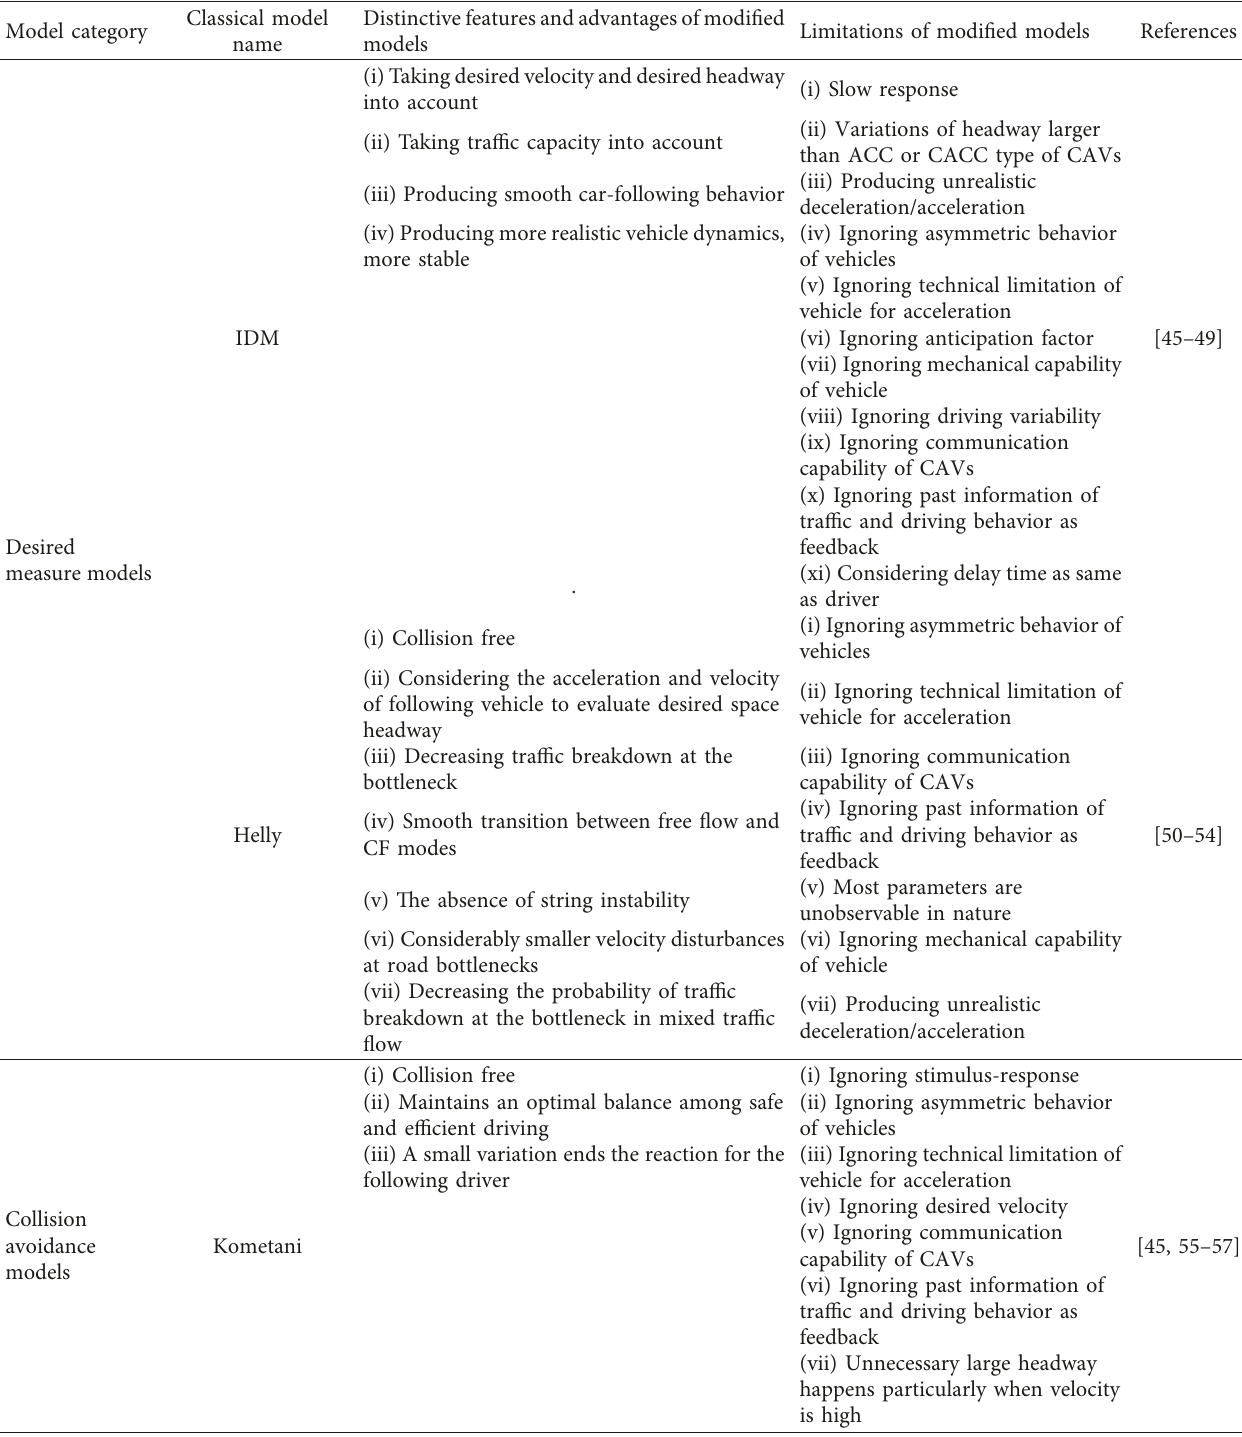
Table 1: Classical and modified car-following